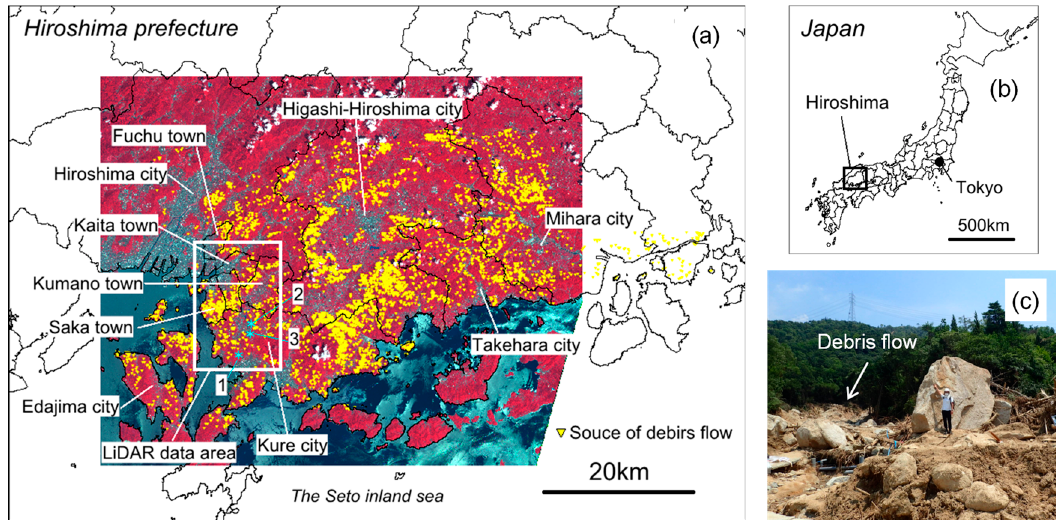
Figure 1. ( a ) Target area in Hiroshima prefecture, Japan. Background image is the post-event satellite Sentinel-2 image. Yellow triangles indicate sources of debris flows in the 2018 event [35]. White rectangular indicates LiDAR data area analyzed in this study. Blue stars (1-3) represent typical unaffected areas selected for accuracy assessment of LiDAR data. ( b ) Location of Hiroshima prefecture. ( c ) Ground photograph of debris flow with large blocks flowed during the 2018 event in Kumano town.